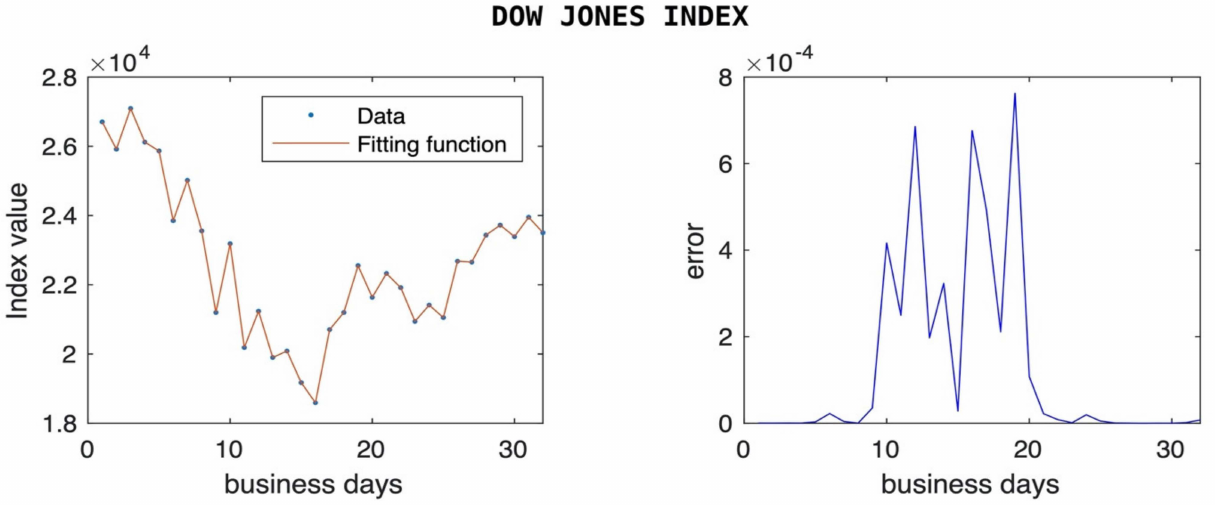
Figure 1. Fitting Dow Jones Index Average (DJIA) values during 2020 stock market crash. Fitting function of Dow Jones Index values from 1 March 2020 to 15 April 2020. N = 80, error range is [3.7289 × 10 − 11 , 3.2482 × 10 − 5